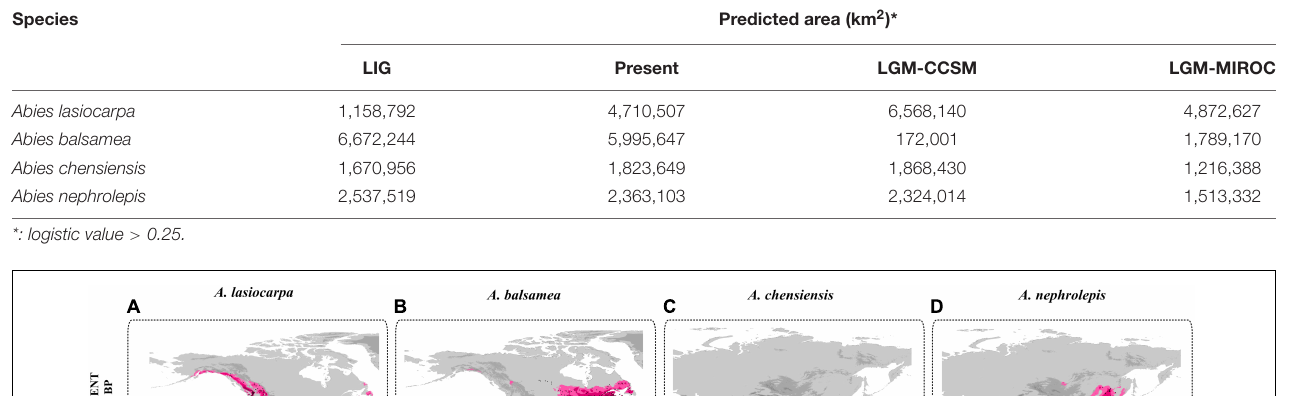
TABLE 4 | Predicted potential distribution of four fir species during different time periods. Species